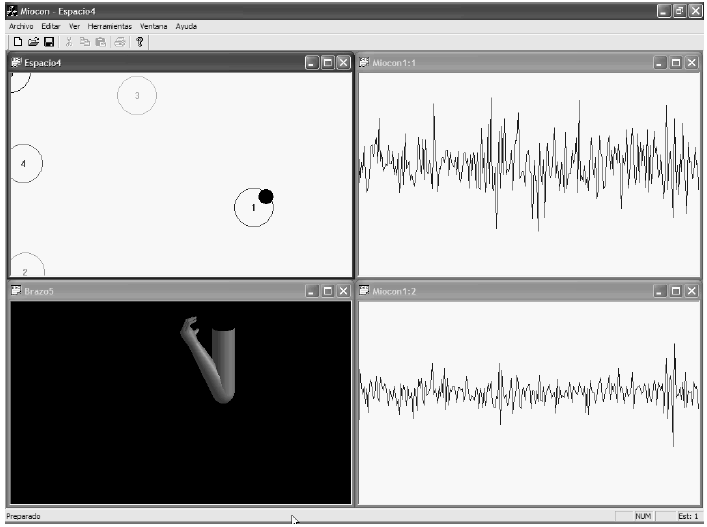
Figure 18. Increased biceps activity (top EMG graph). The detected state is #1, which is assigned to arm